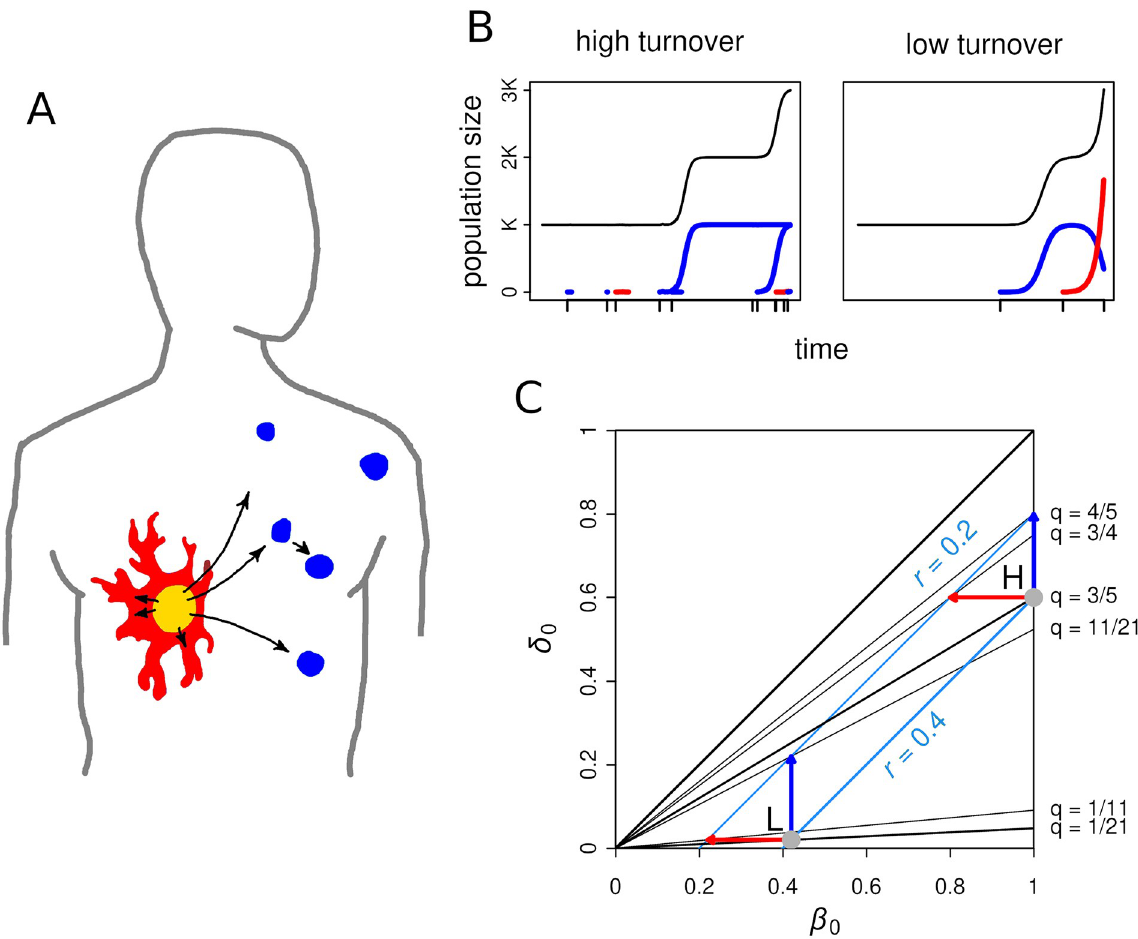
Fig 1. Modelling cancer progression via metastasis and/or driver mutation events. A Primary tumour is assumed to have reached its present growth potential (yellow). It can progress to the next epoch of growth via de novo driver mutation that, for example, induces angiogenesis (red), or via seeding metastasis (blue). B Simulated example trajectories at high (low) cell turnover with β 0 = 1.0, δ 0 = 0.6, ( β 0 = 0.42; δ 0 = 0.02). Black line shows total population size. Blue line shows metastatic tumour population sizes and red line shows cell population containing driver mutation. Tick marks on the time axis show metastasis and mutation events, some of which go extinct due to fluctuations that are stronger in high turnover tumours. C The simulation experiment setting on a birth rate–death rate plane. The light grey dots marked H and L show the high turnover and low turnover cases, respectively. The arrows show the changes after applying cytostatic (red) or cytotoxic (blue) medication with magnitude Δ = 0.2, which keeps the overall growth reduction constant. The net growth rate r (light blue lines) and stochastic extinction risk q = δ 0 / β 0 (thin black lines) of each scenario is also shown.